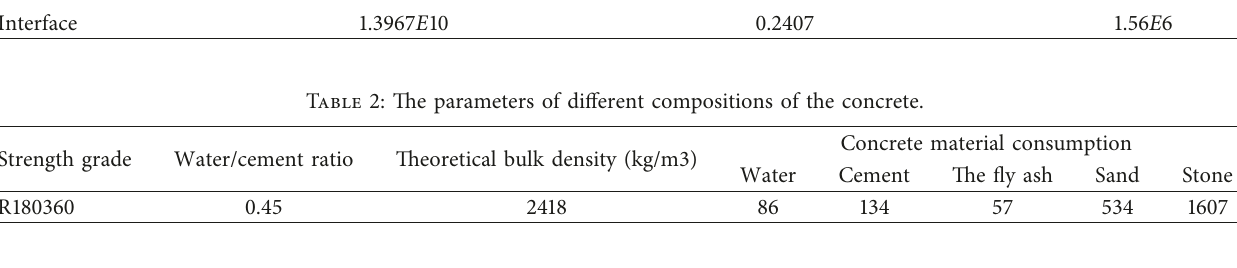
Table 3: The model of the concrete specimens under stress.